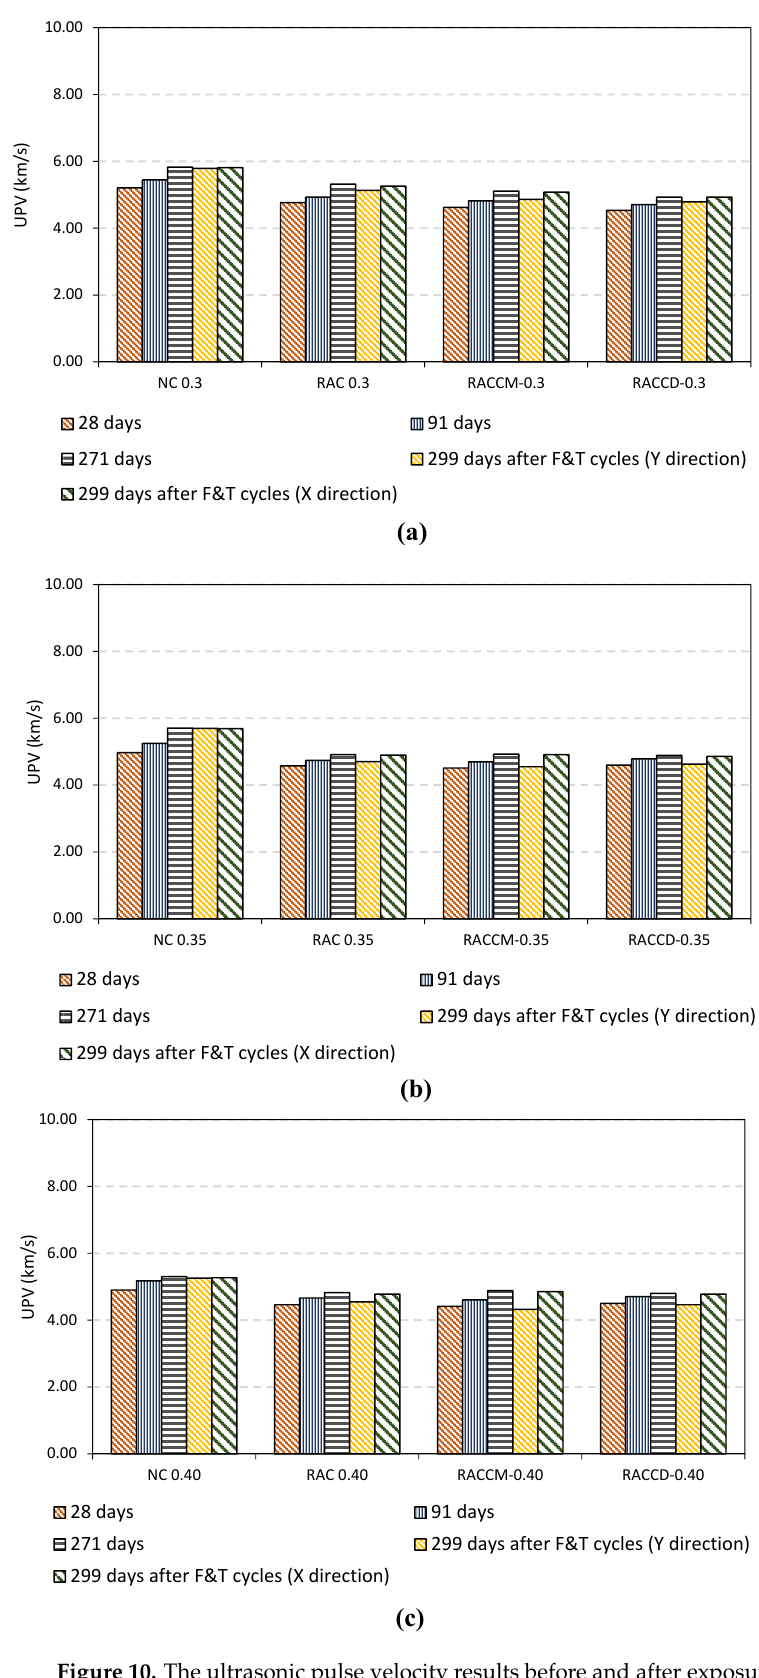
Figure 10. The ultrasonic pulse velocity results before and after exposure to freeze-thaw; ( a ) w/c ratio 0.30, ( b ) w/c ratio 0.35, and ( c ) w/c ratio 0.40.